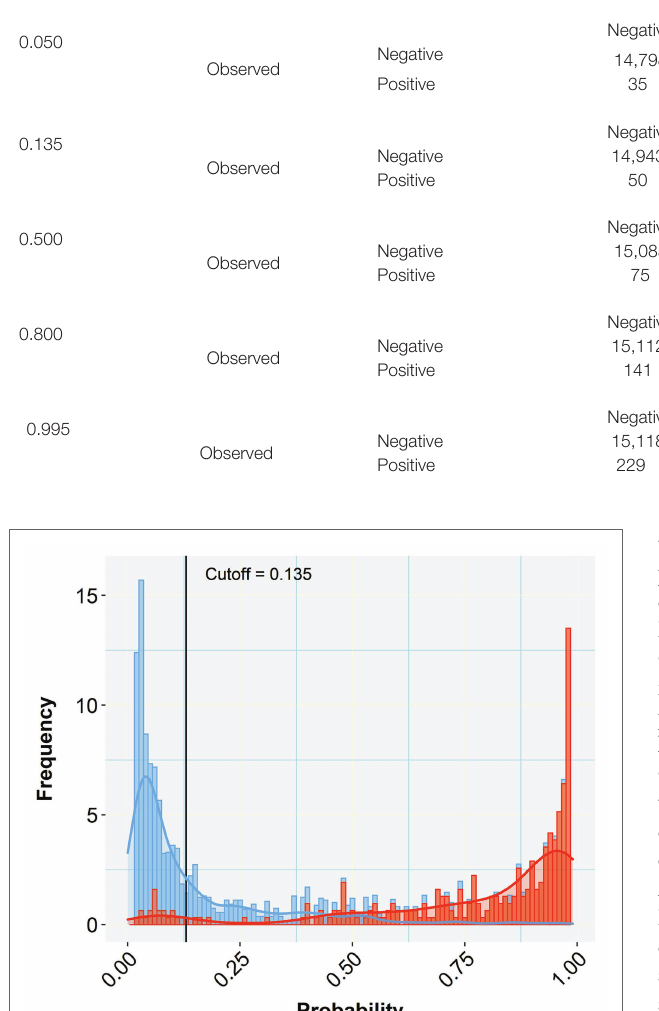
TABLE 3 | Comparison of diagnostic performance indicators at representative cutoffs generated from the respective confusion matrices of observed against predicted by the trained classifier algorithm pixel status in the test subset ( n = 19,593). Cutoff